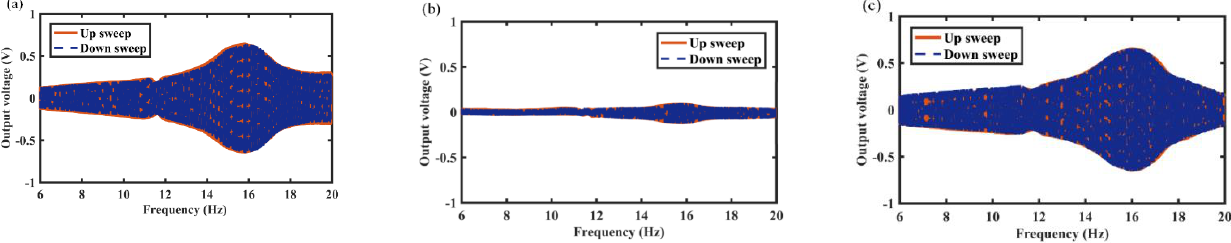
Figure 10. Frequency sweep response of the MCEEH with spring wire diameter of 0.6 mm: ( a ) coil 1; ( b ) coil 2; ( c ) coil 3.